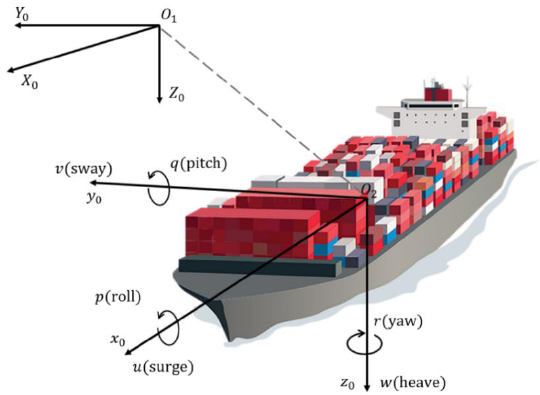
Figure 2. Reference frames for ships.